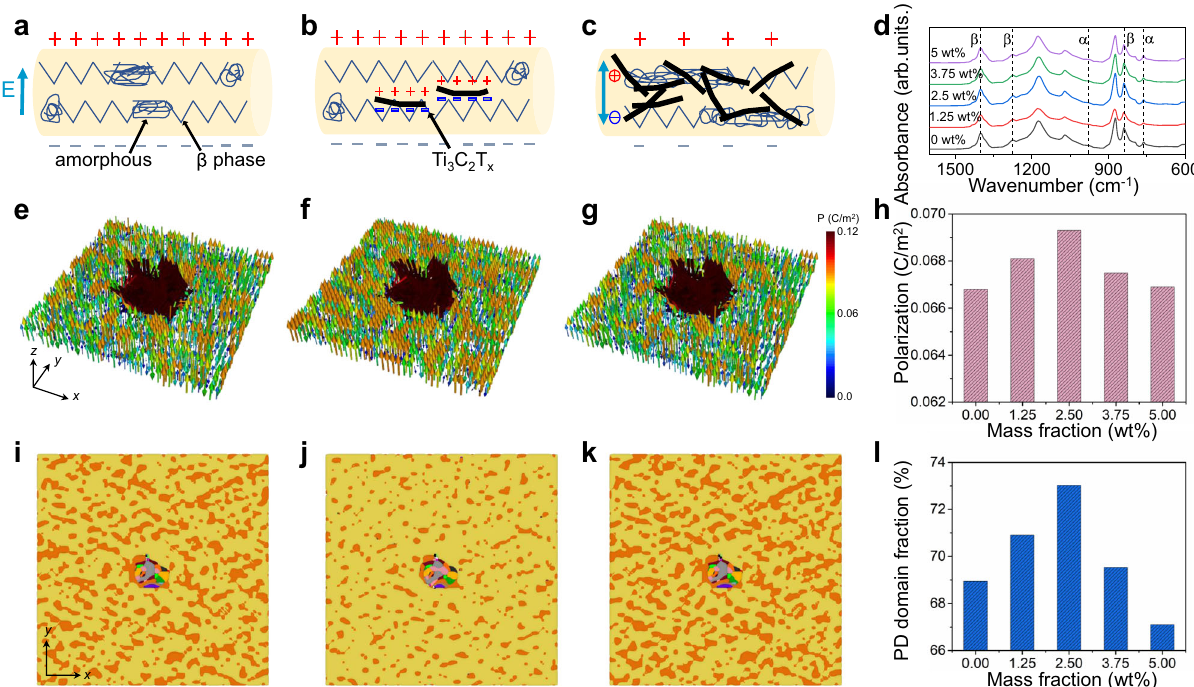
Fig.4|Mechanismofas-electrospunnano fi bersviadopingMXenenanosheets. a – c Schematic of the polarization process of electrospun nano fi bers doped with a no MXene, ( b ) proper amount of MXene, and c excessive amount of MXene. d Fourier transform infrared (FTIR) spectrum of the undoped textiles and